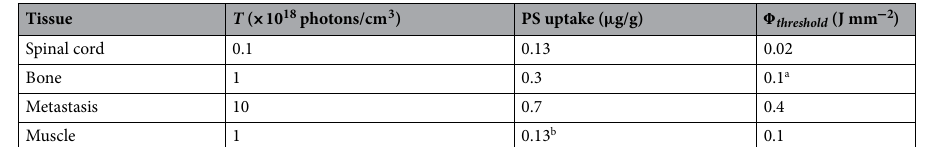
Table 3. PDT dose threshold values for each region in the 3D model. b in a porcine model 30 . Assumed to be similar to the spinal